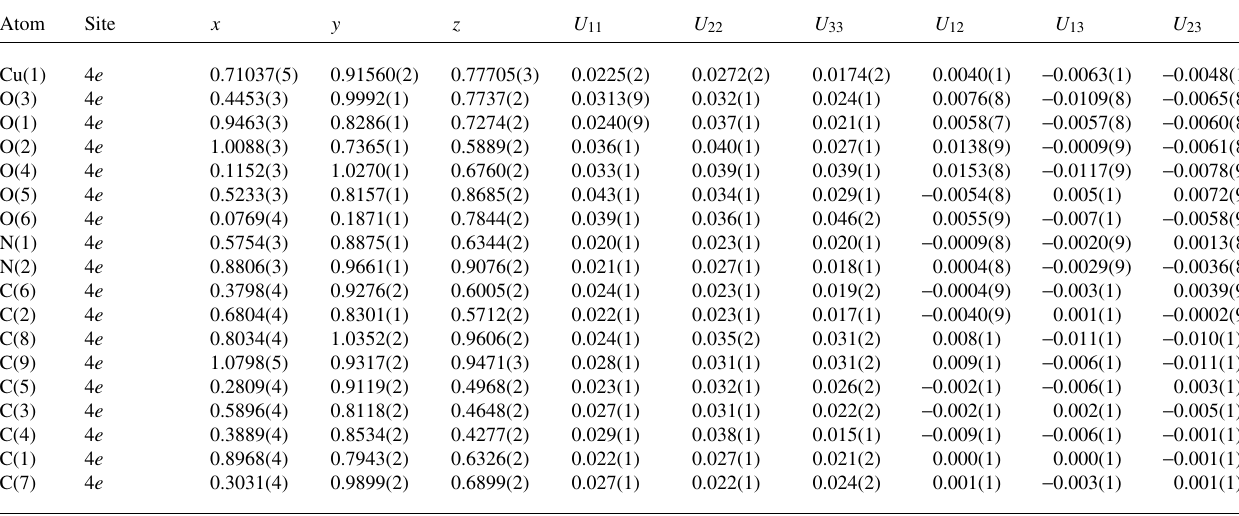
Table 3. Atomic coordinates and displacement parameters (in Å 2 ) .